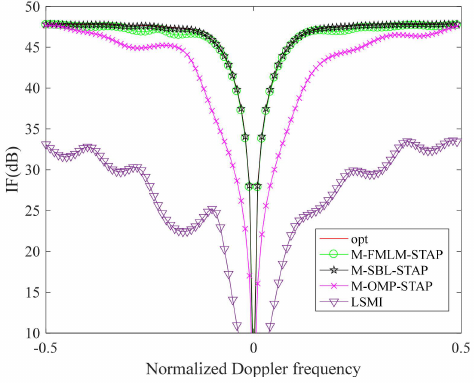
Figure 3. IF curves in the ideal case.